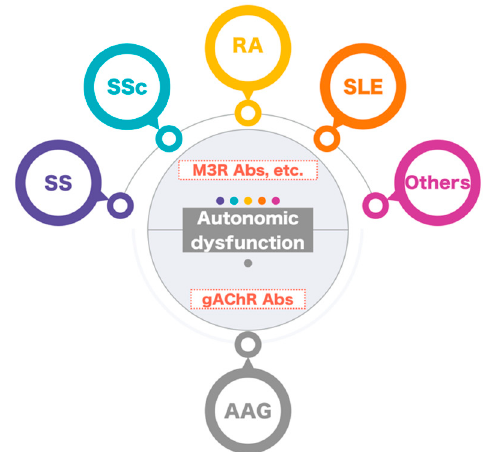
Figure 2. Anti-gAChR autoantibodies and autonomic dysfunction in autoimmune rheumatic diseases.